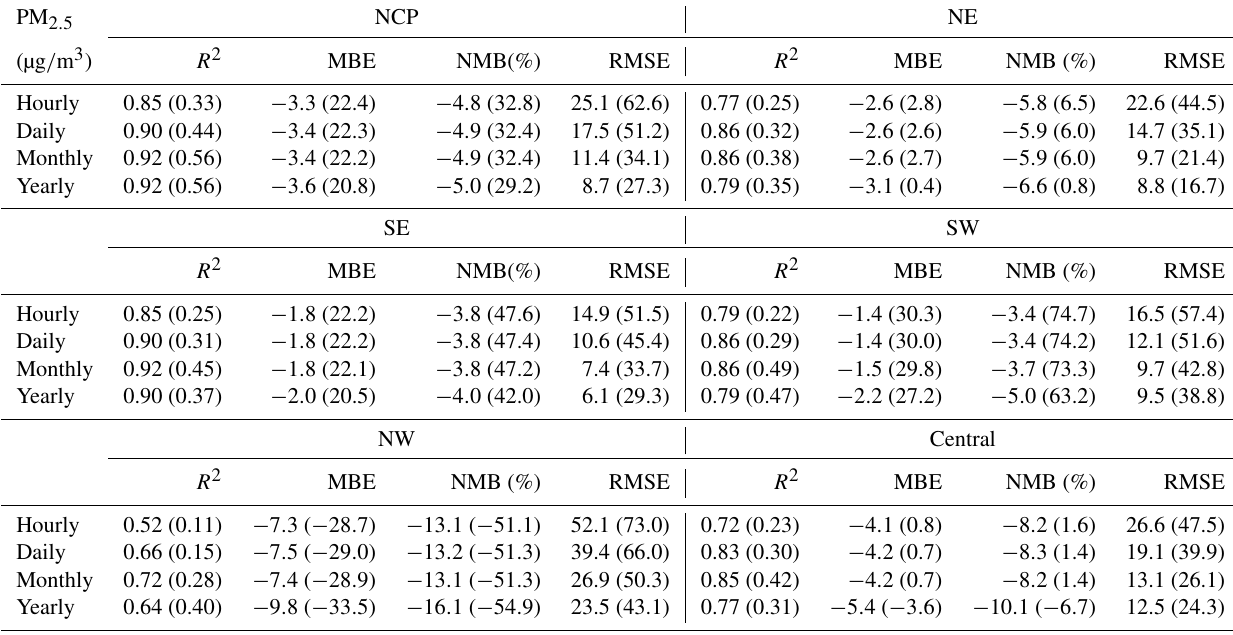
Table E1. CV results of the reanalysis (outside brackets) and base simulation (in brackets) for PM 2 . 5 concentrations in different regions of China on different temporal scales.